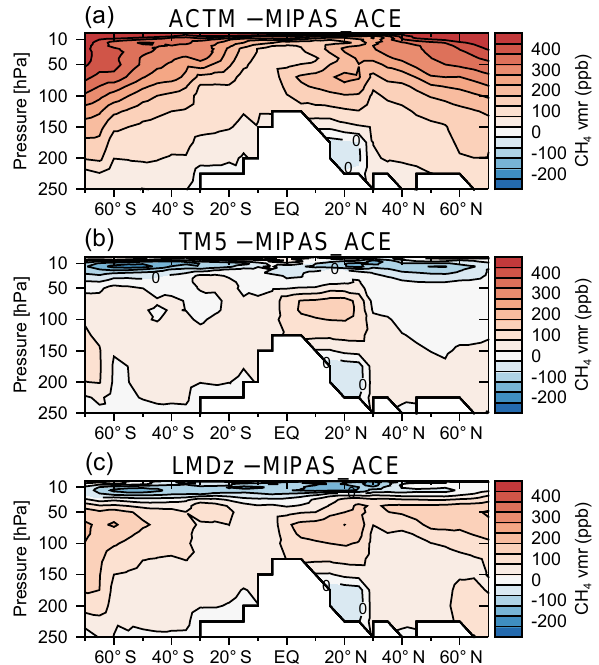
Figure 4. Model–MIPAS_ACE differences of stratospheric CH 4 volume mixing ratios (vmr) in parts per billion (ppb). Zonally aver- aged CH 4 vmr differences are annual means for the year